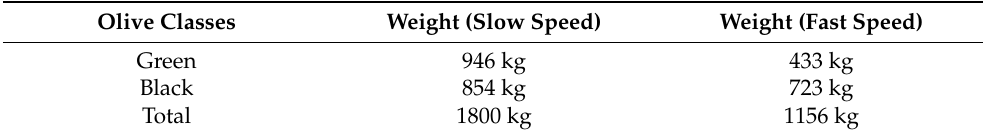
Table 3. Weight of olives based on speeds (slow and fast).